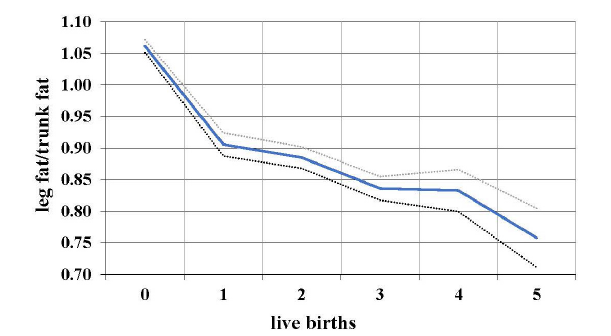
FIGURE 2 | Relationship between live births and leg/trunk fat ratio in 7,753 women 12–49, with 95% confidence intervals, NHANES 1999–2006.